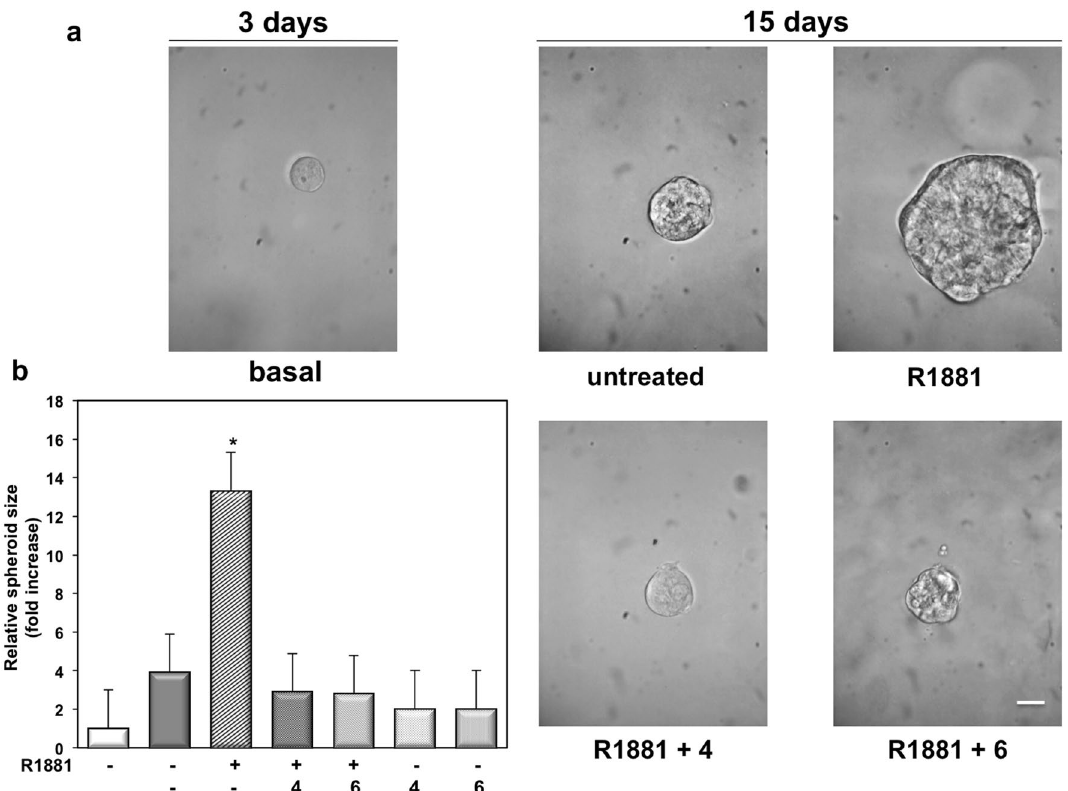
Figure 5. TRPM8 antagonists, 4 and 6, inhibit the androgen-induced increase in LNCaP cell spheroid size. LNCaP cells were employed in 3D cultures and 3 days after the cell’s embedding in Matrigel, representative images were acquired as described in “Methods”. 3D cultures were left untreated or treated with 10 nM R1881, in the absence or presence of the indicated compounds (at 1 μM) for 15 days. Shown are phase-contrast images, representative of 3 different experiments and captured at 15th day. Scale bar, 100 μm. In ( b ), the spheroid size was calculated as described in “Methods” and expressed as fold increase in the relative spheroid size. Means and SEMs from three different experiments are shown. * p < 0.05 for the indicated experimental points vs . the corresponding untreated